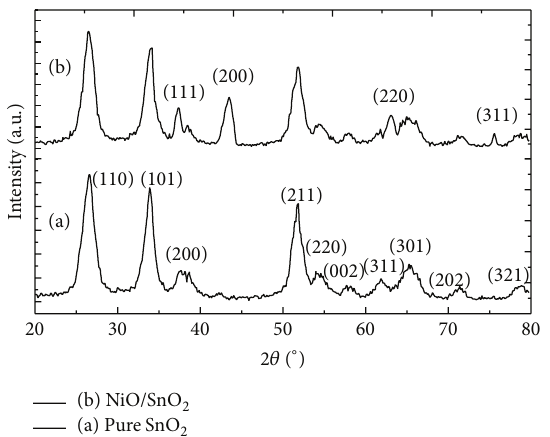
Figure1:XRDpatternsof(a)pureSnO 2 and(b)NiO/SnO 2 compos- ites.